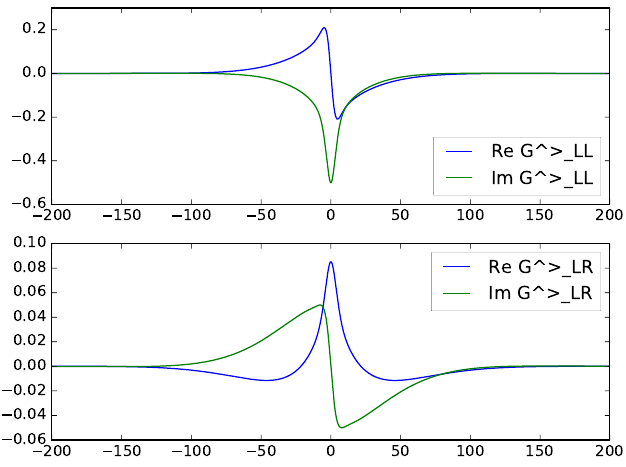
Figure 13 . Wightman function G > for two coupled q = 4 SYK with J = 0 . 5 , µ = 0 . 05 , β = 40